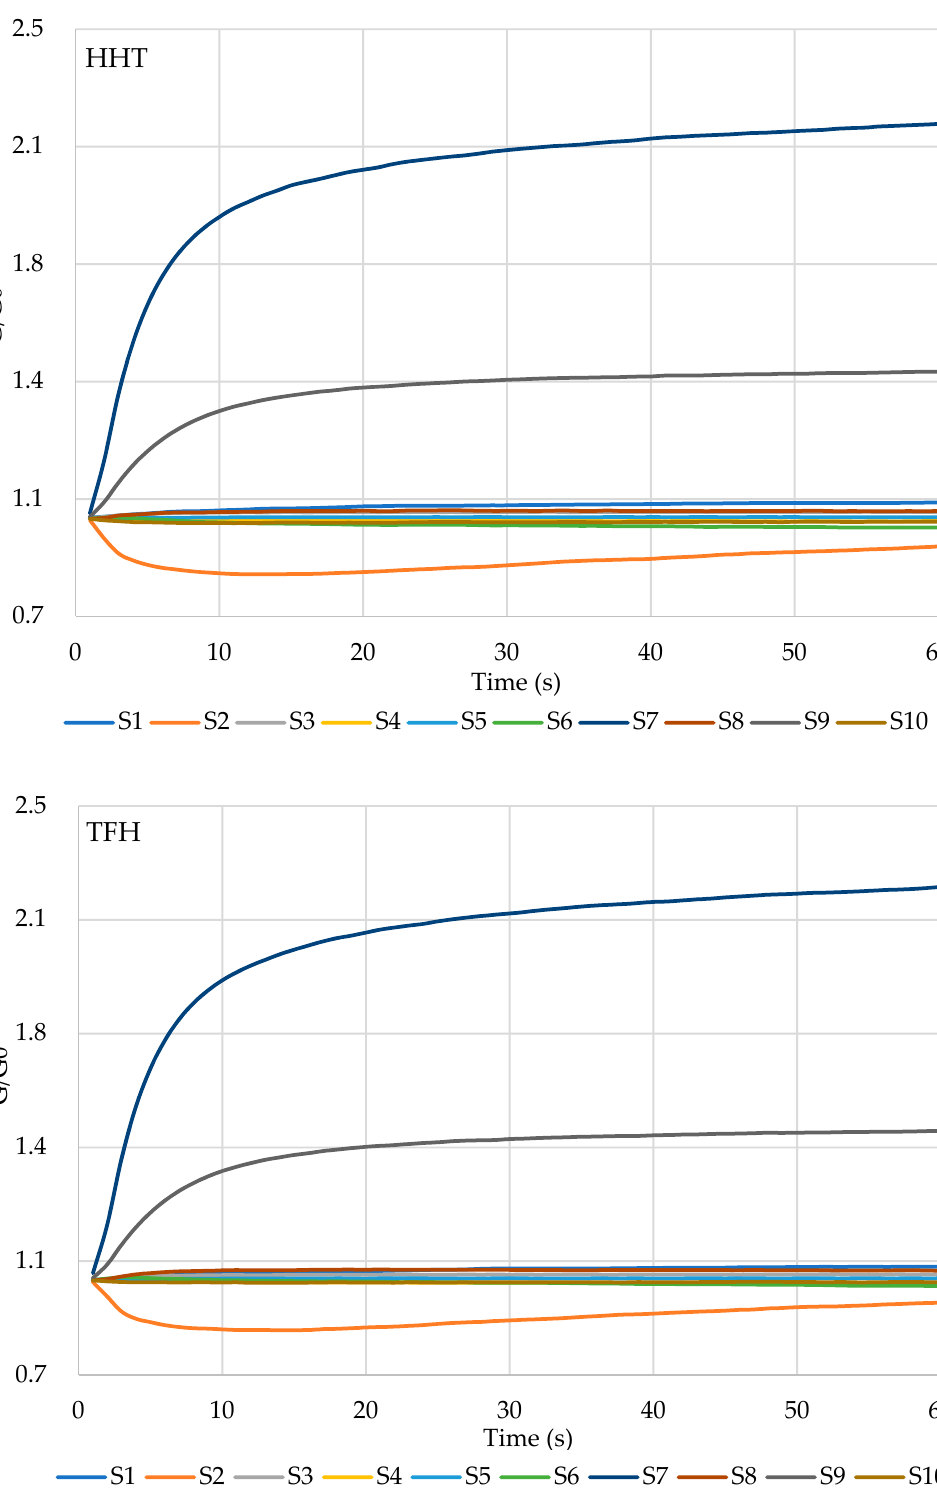
Figure 2. Response curves of E-nose sensors (S1–S10) to DHM, DXC, HHT and TFH.